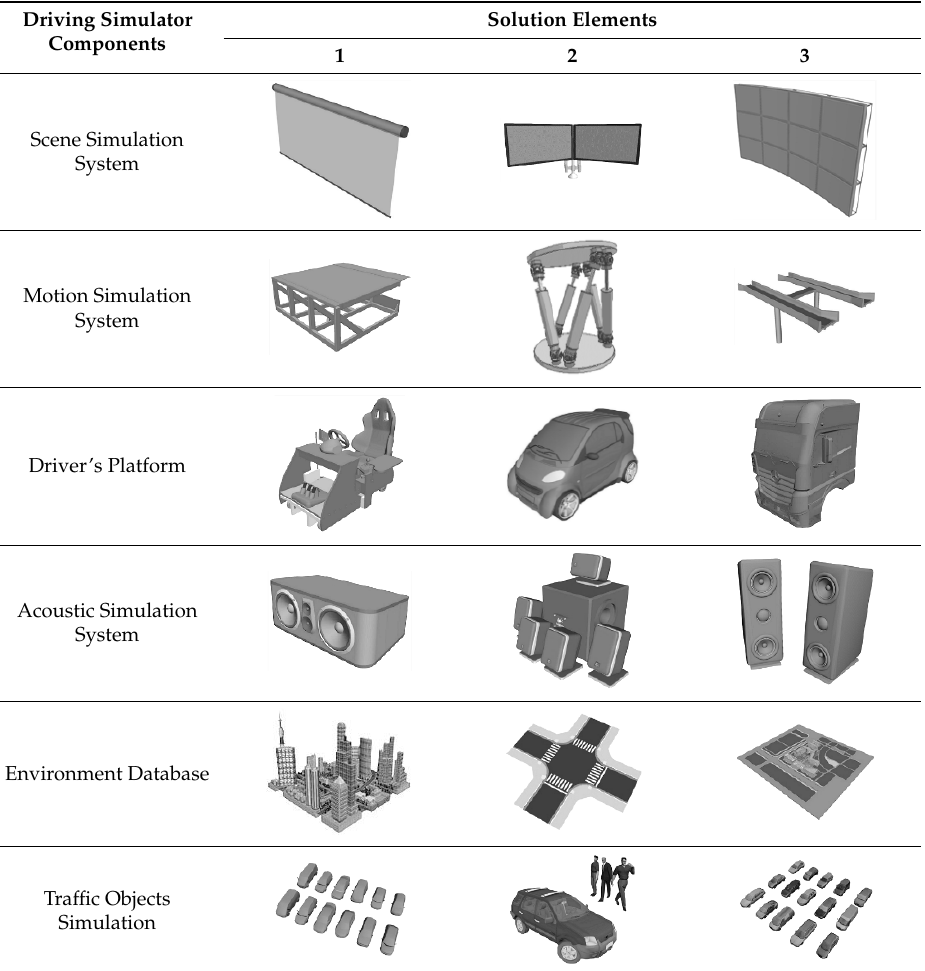
Table 3. Morphological box for driving simulator components (excerpt) [7].